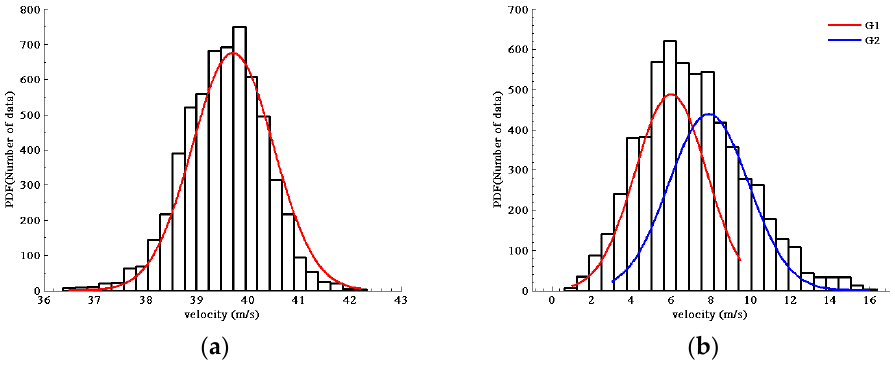
Figure 13. Velocity distribution of monitor points: ( a ) P1; ( b ) P2.